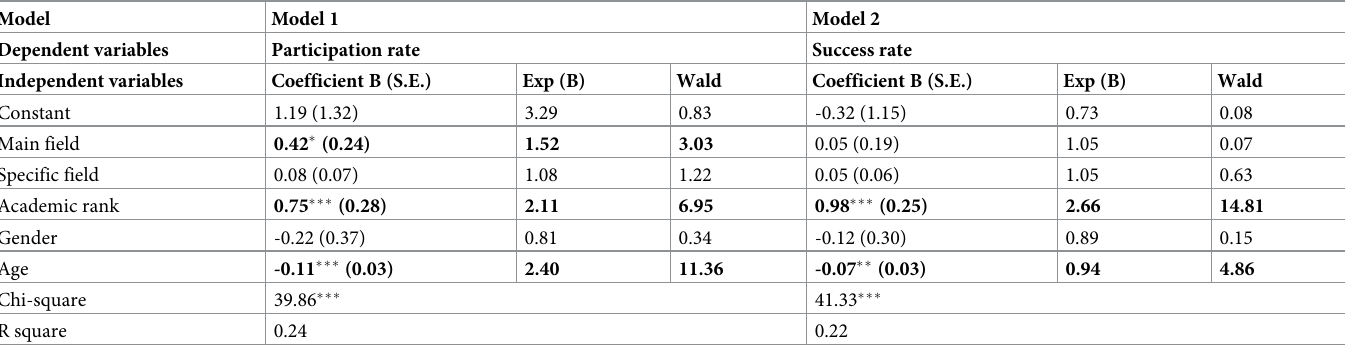
Table 7. Logistic model estimation